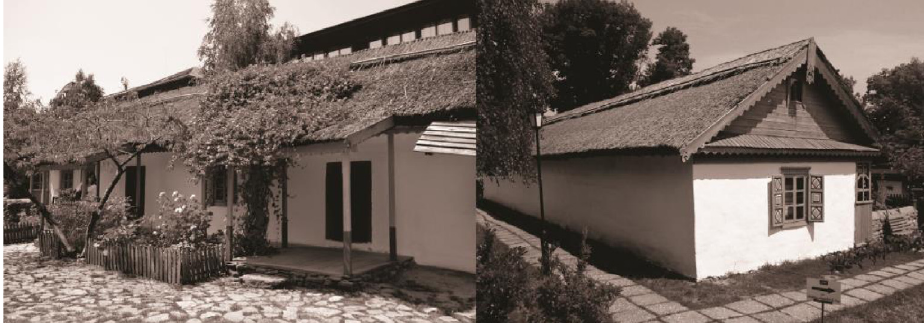
Fig. 1. A traditional house from Jurilovca, Tulcea, XIX-th Century (South-Eastern Romania).